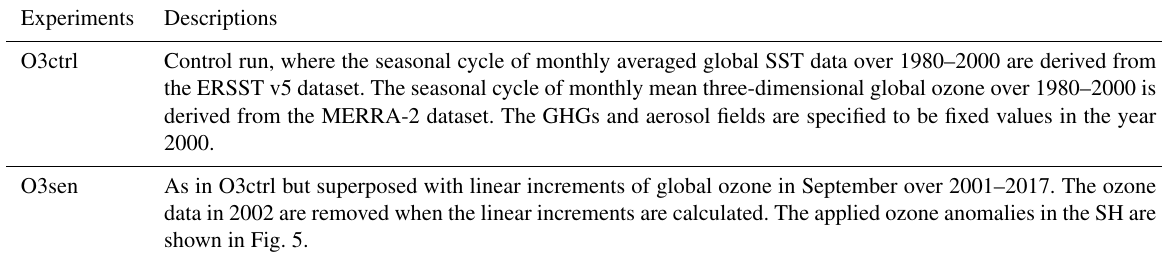
Table 2. Configurations of experiments for the ozone recovery